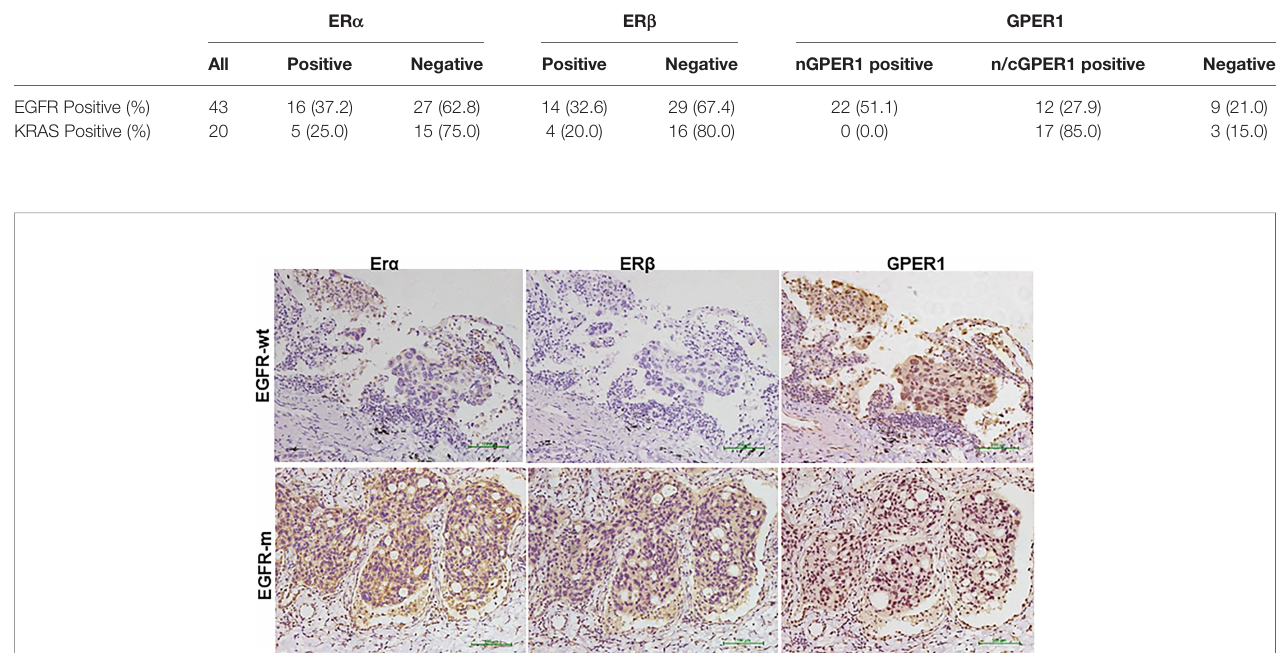
TABLE 2 | Frequency of expression of estrogen receptor (ER) a ,ER b and GPER1 in EGFR and KRAS mutated tumors.